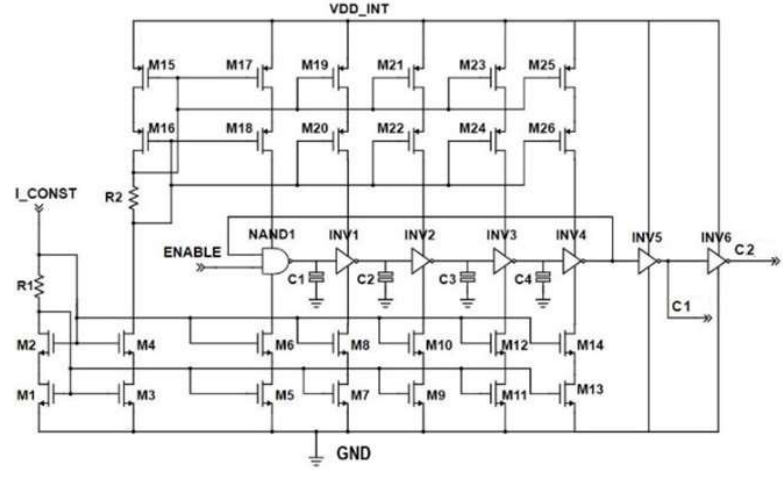
Figure 3. Proposed design architecture for the ring oscillator circuit.